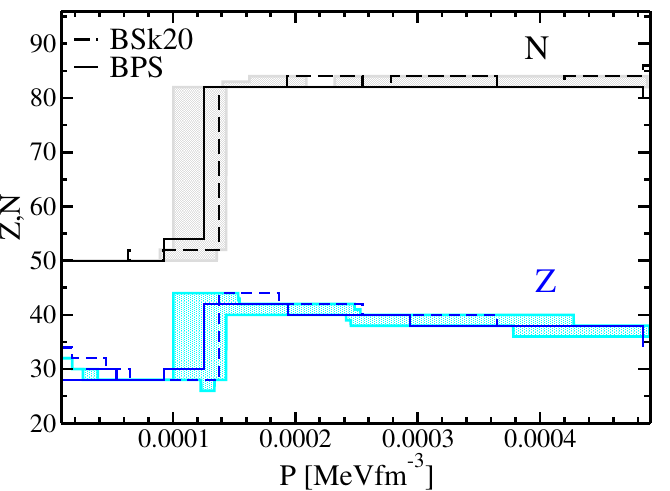
Figure 12. Variations of Z and N with pressure in the outer crust for the BSk20 and BPS models. The shaded area represents the regions covered by the Monte Carlo procedure detailed in the text and obtained using the DZ10-GP model. See text for